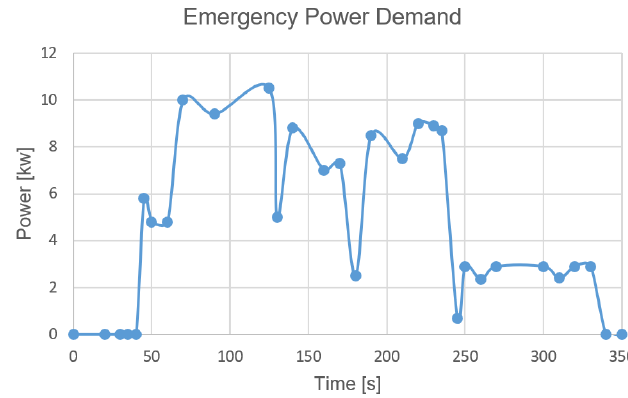
Figure 2. Power demanded in the system